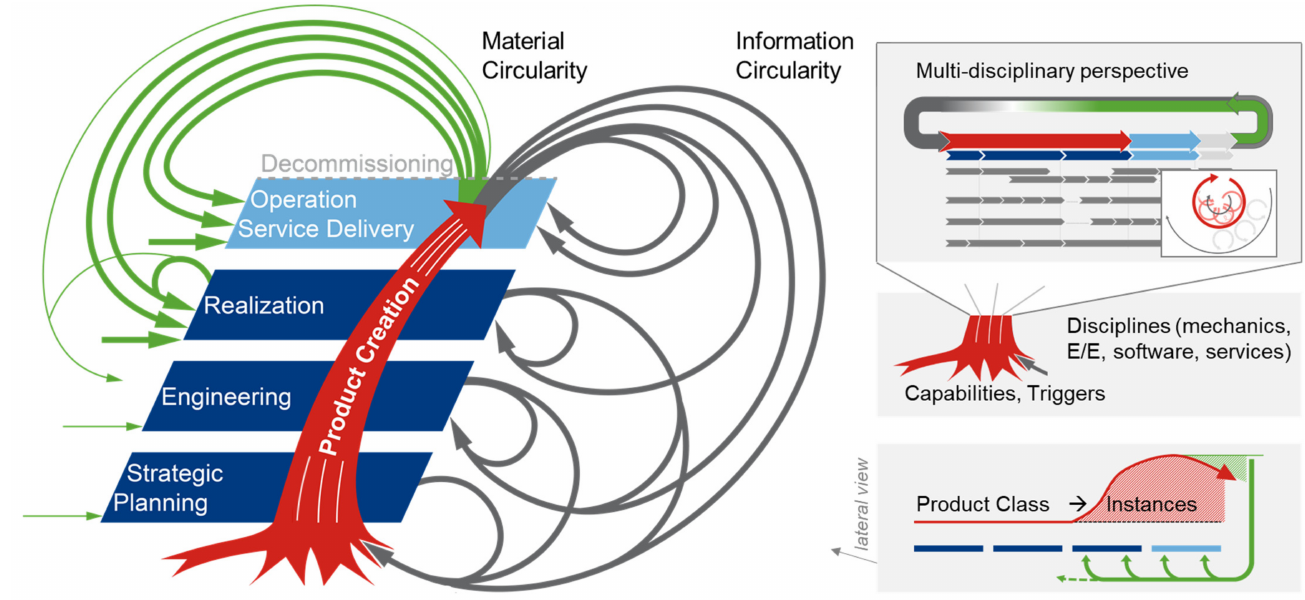
Figure 6. Visualization of the generic Product Lifecycle (gPLC): Circular Economy and Product Creation as drivers; material, ideas, technologies and capabilities as inputs and roots of the cycle; multi-disciplinary products bundled with services as types and instances along joint cycles and